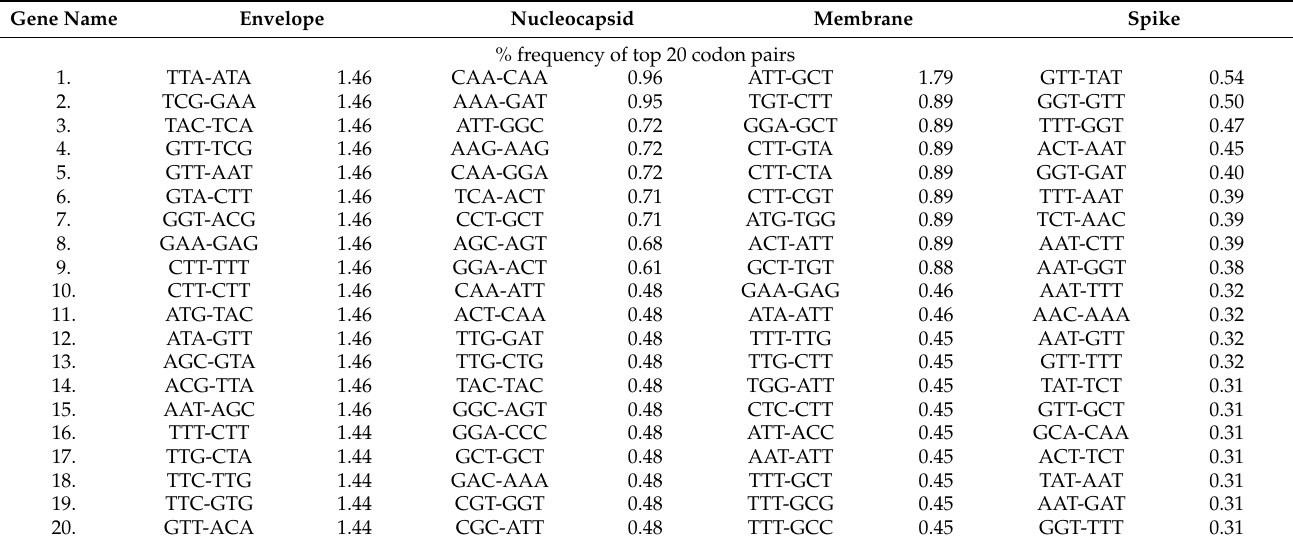
Table 4. Percent frequency of top 20 high occurrence codon